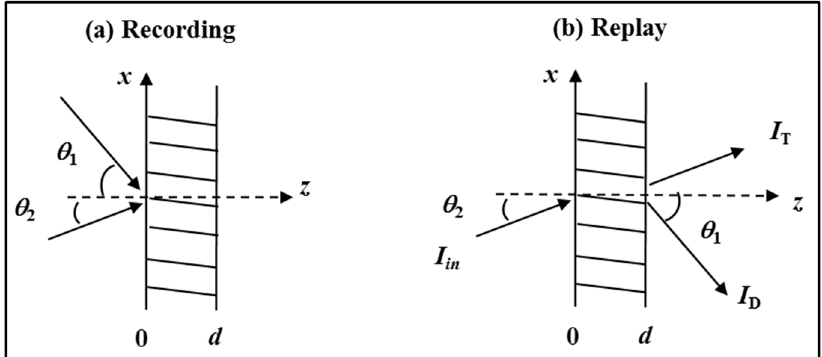
Figure 10. ( a ) Recording (exposing); and ( b ) replay of a volume transmission gratings. I in is the incident intensity of the replay wave, and I T and I D denote the transmitted and diffracted intensities, respectively.